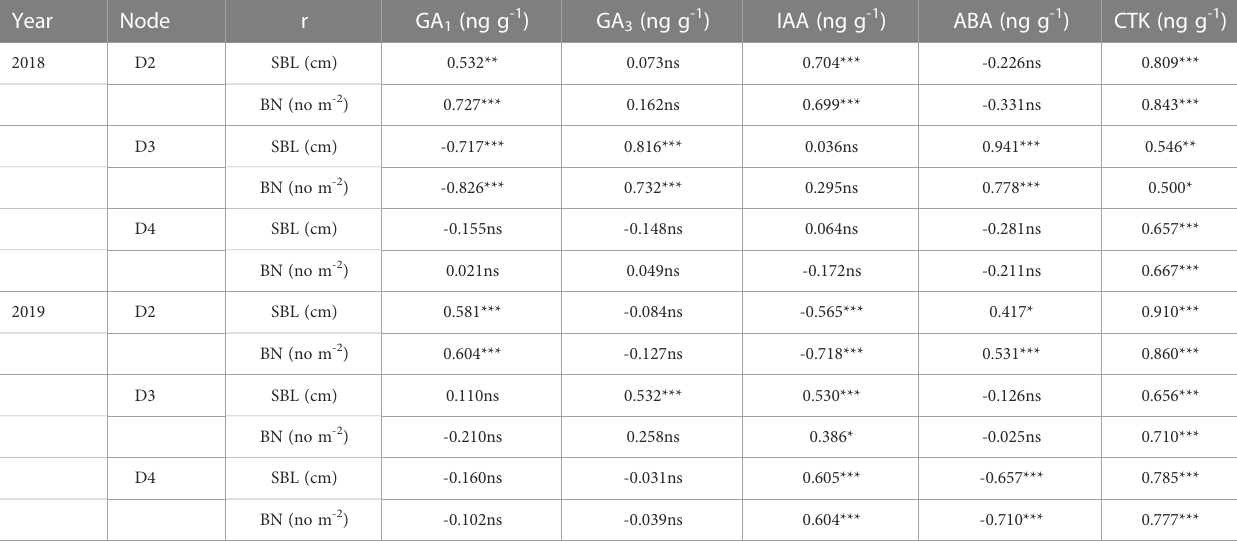
TABLE 4 Correlation between endogenous hormones of stems and buds at each node 15 days after treatment and single bud length and bud number per area in maturity stage of the main crop in 2018 and 2019. Year Node r GA 1 (ng g -1 )